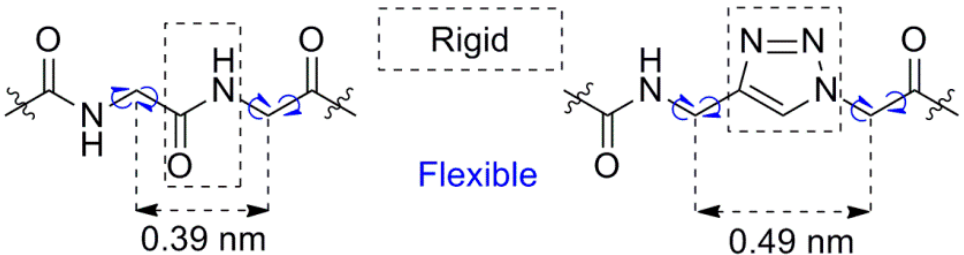
Figure 2. General comparison of trans peptide bond and 1,4-disubstituted 1,2,3-triazole ring as trans peptide bond non-classical bioisostere, adapted from the work of [37]. Every such triazole ring modification leads to backbone elongation and different conformational latitude.